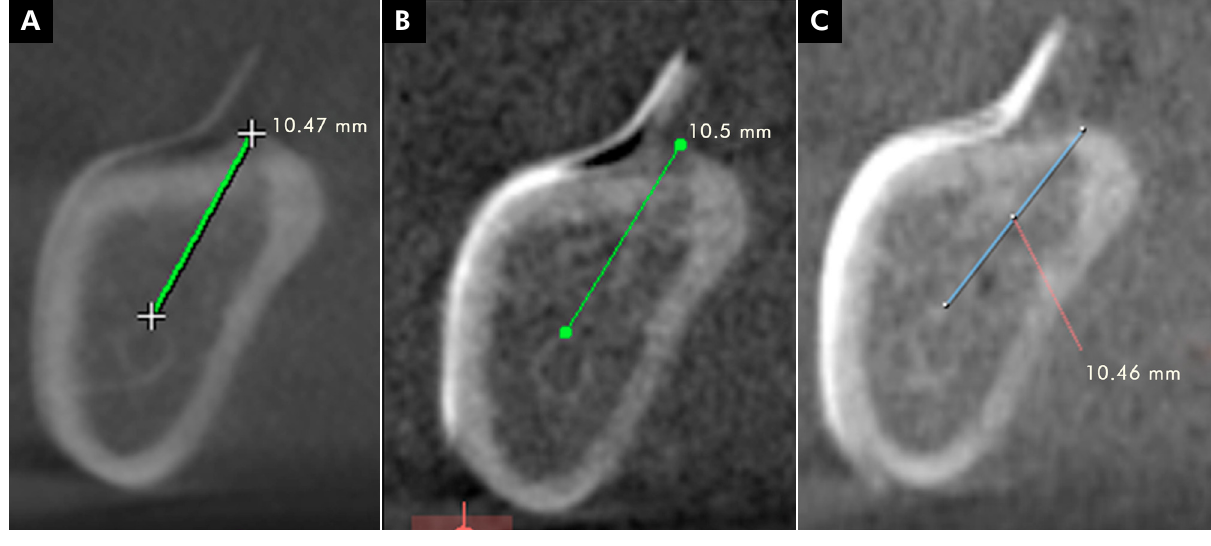
Figure 1. Distance from the superior cortical of the mandibular canal to the highest point of the alveolar bone crest: (A) XoranCat ® ; (B) KDIS3D ® ; and (C) OnDemand3D ®